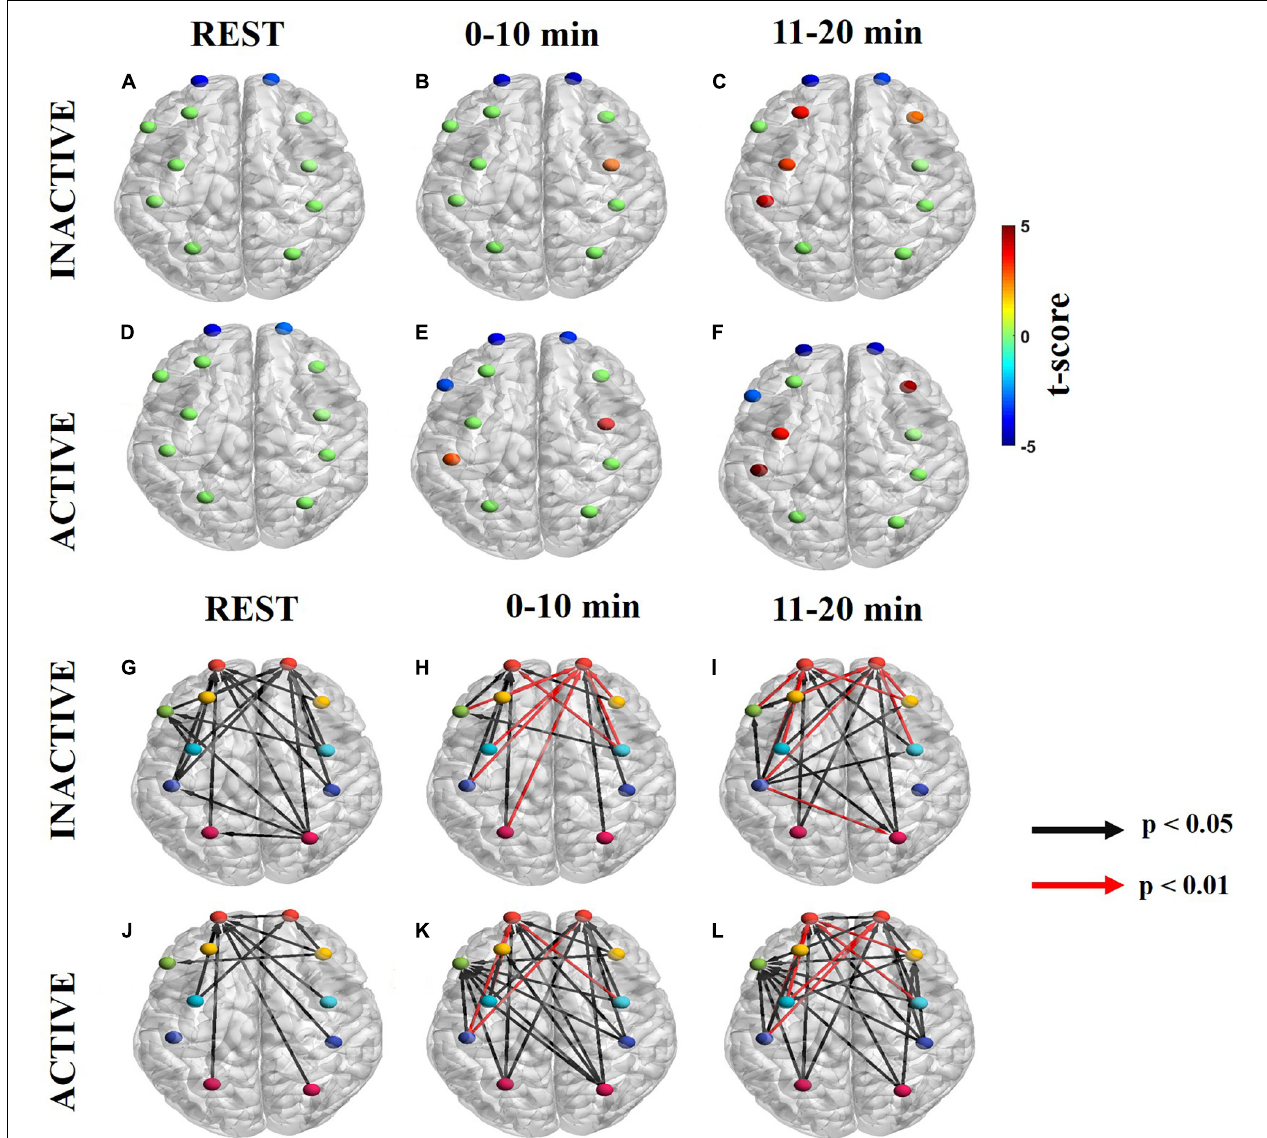
FIGURE 4 | Significant dPTE and DC in the neurogenic frequency band for inactive and active subjects during the handgrip task for (cid:49) HbO. Directed PTE t -values for each ROI as a color-coded map for inactive subjects (A–C) and active subjects (D–F) . Hot (yellow-reds) and cold (light blue-dark blue) colors indicate information outflow and inflow, respectively. Arrows indicate statistically significant information flow between functional regions for inactive (G–I) and active subjects (J–L) . Black arrows ( p < 0.05); Red arrows ( p < 0.01). Eleven regions of interest (ROIs) were mapped: left and right frontopolar (lFP; rFP) (red), left and right pre-frontal cortex (lDLPFC; rDLPFC) (yellow), Broca’s area (green), left and right pre-motor cortex (lPMC; rPMC) (light blue), left and right primary motor and sensory cortical (lM1/S1; rM1/S1) areas (purple), and left and right sensory association cortex (lSAC; rSAC)